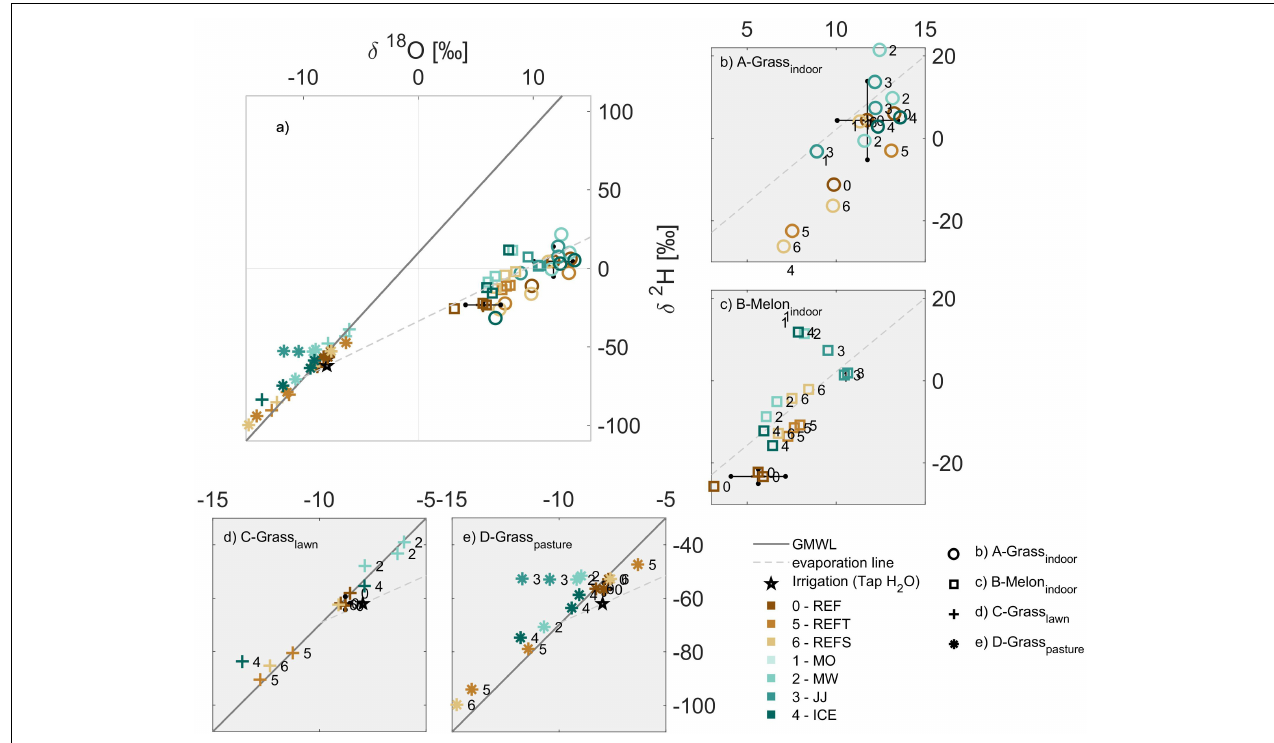
FIGURE 2 | Dual isotope space ( δ 18 O and δ 2 H) including all extracted plant water samples, the global meteoric water line (solid gray line), the evaporation line calculated as in Benettin et al. (2018) (dashed line) using the median irrigation water (star). The median and error of the REF are indicated as cross hairs with black closed circles. (a) Symbols indicate the indoor grass (circles), melon (square), campus lawn grass (cross), grass from the pasture (asterisk) and irrigation water (star). Different colors indicate cryogenic vacuum extraction (REF), simulated transport using REF (REFT), simulated storage using REF (REFS) and the different extraction methods MO, MW, JJ, and ICE (mojito, microwave, jam jar and ice cube, respectively). The side panels show data for each plant group (A-D) separately (b–e)